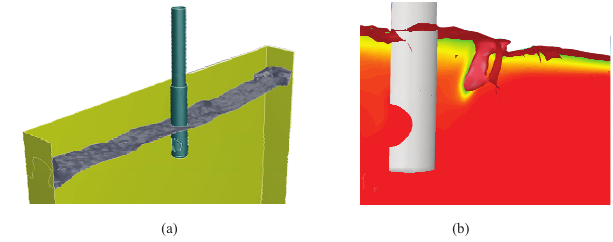
Figure 5. Metal flow results showing formation of (a) standing wave and (b) vortex and slag entrapment.